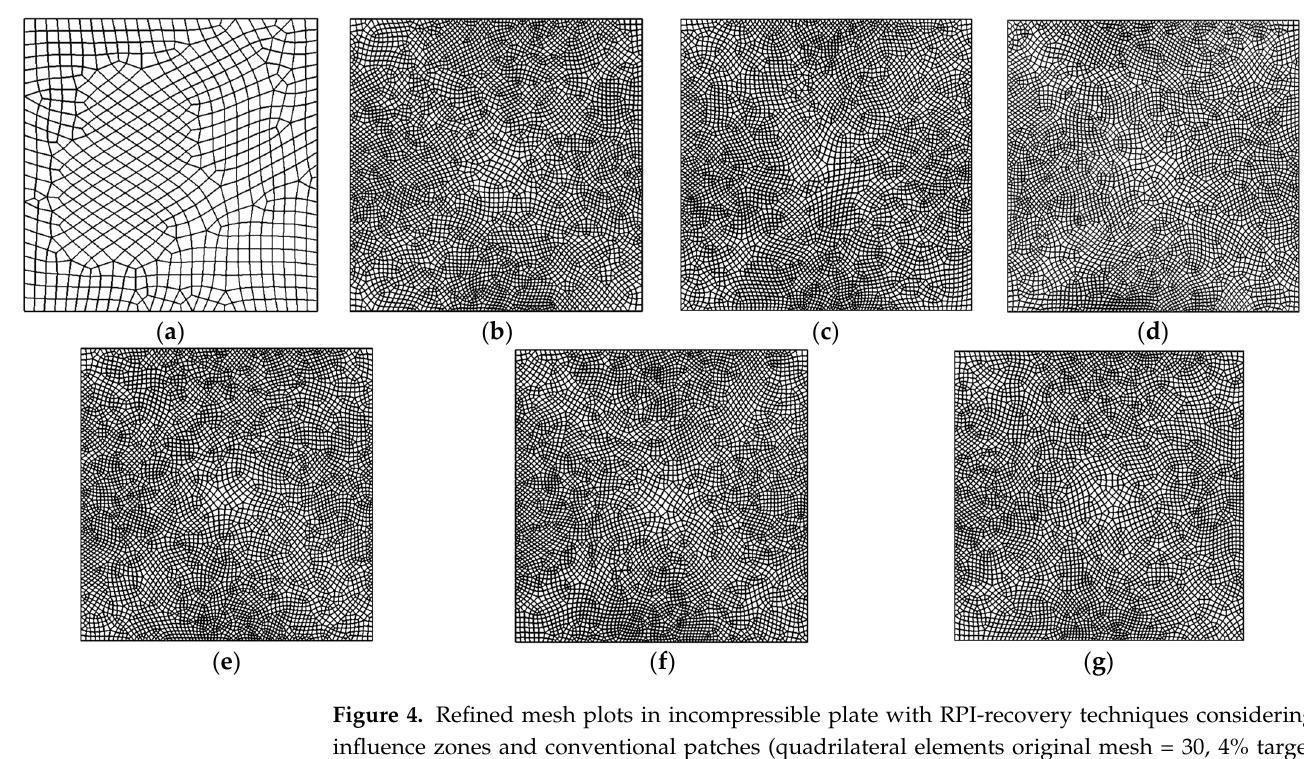
Figure 4. Refined mesh plots in incompressible plate with RPI-recovery techniques considering influence zones and conventional patches (quadrilateral elements original mesh = 30, 4% target accuracy). ( a ) Mesh (original). ( b ) LS (conventional patch, ZZ). ( c ) RPI (conventional patch, MQ). ( d ) RPI (conventional patch, TSP). ( e ) RPI (influence zones, MQ, cirular). ( f ) RPI (influence zones, TSP, cirular). ( g ) RPI (influence zones, TSP, rectangular).